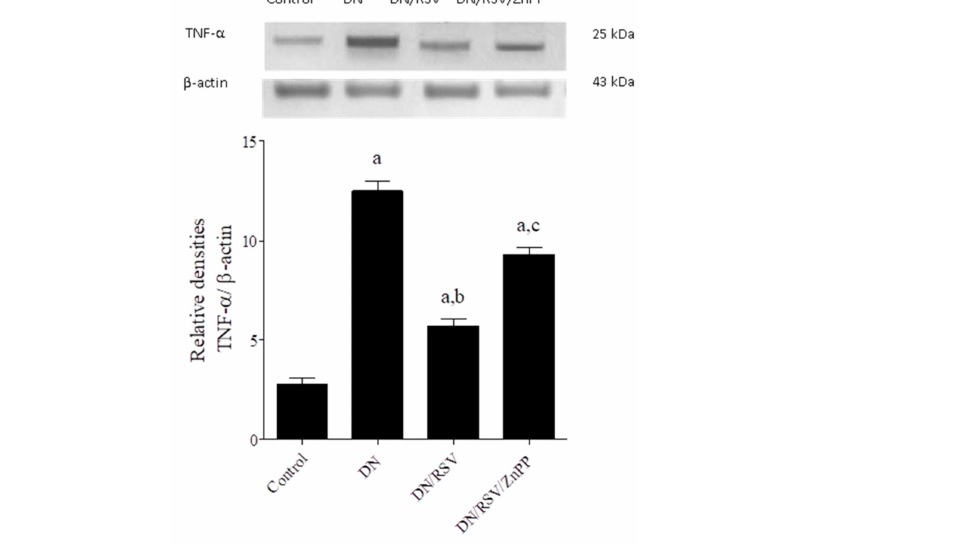
Figure 3. Effect of rosuvastatin (RSV) on renal Western blot analysis of tumor necrosis factor (TNF)- α expression in diabetic nephropathy (DN) in rats. ZnPP, zinc protoporphyrin-IX. Repre- sentative Western blot ( upper panel ) showing TNF- α immune reactive protein and β -actin bands. The graph shows relative densitometry of TNF- α / β -actin ratio ( lower panel ). Values are a repre- sentation of 3 blots as ratio means ± S.E.M and results are considered significantly different when p < 0.05. a Significant difference compared to control, b significant difference compared to DN group, c significant difference compared to DN/RSV group.